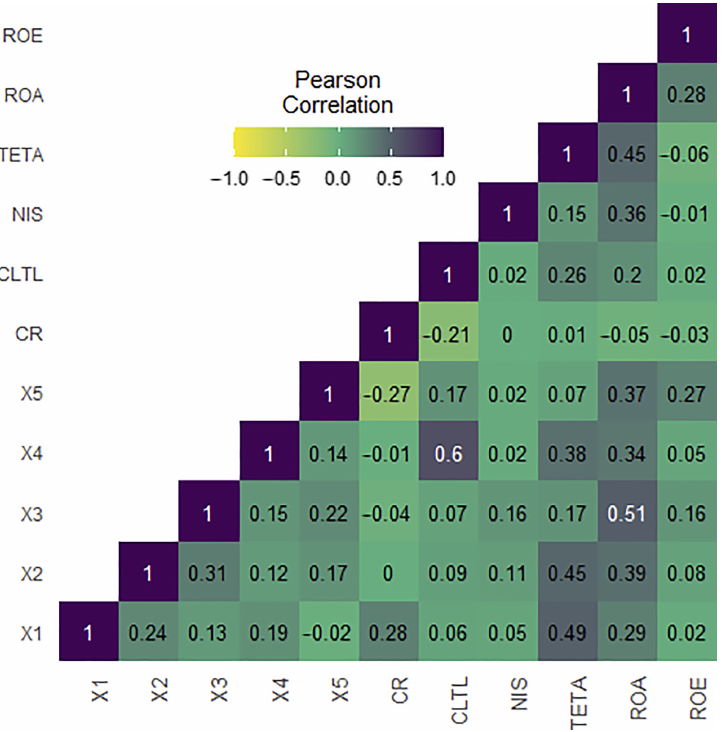
Figure 2. Correlation matrix